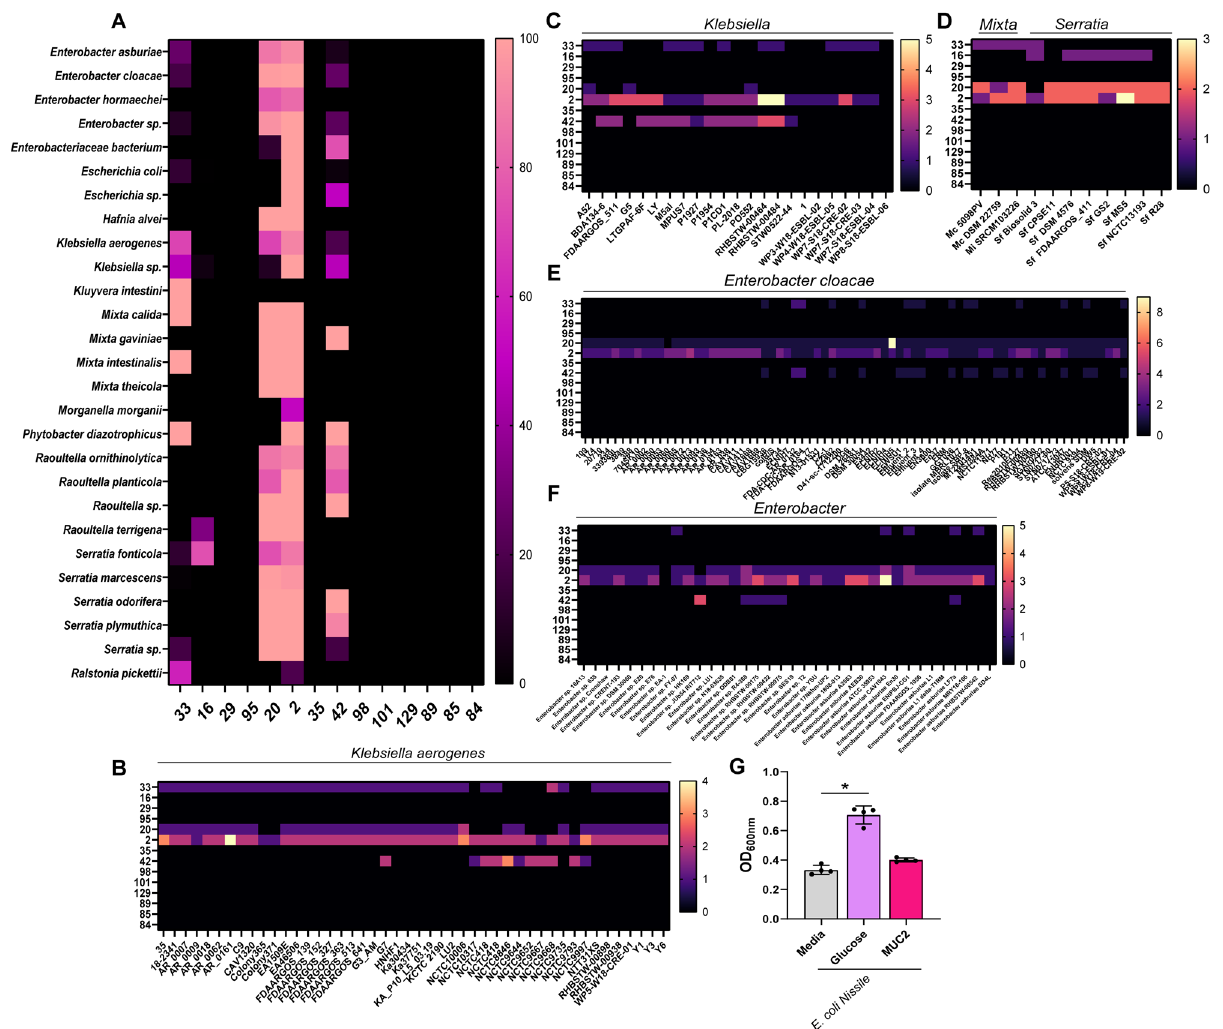
Figure 5. Mucin-related glycosyl hydrolase profiles in the Proteobacteria phlyum. ( A ) Heat map of the Proteobacteria genomes that have at least one gene copy of each mucin-associated GH 33, 16, 29, 95, 20, 2, 35, 42, 98, 101, 129, 89, 85, and 84. Heat map showing the gene copy number of mucin-associated GHs in the strains of ( B ) Klebsiella aerogenes , ( C ) Klebsiella spp., ( D ) Mixta calida, M. intestinalis, and Serratia fonticola, ( E ) Enterobacter cloacae , ( F ) Enterobacter spp. and E. asburiae. ( G ) Growth analysis of E. coli Nissle 1917 in a chemically defined media ZMB1 lacking glucose (media control), with glucose (positive control), or lacking glucose and supplemented with 1 mg/mL porcine intestinal MUC2. Growth was measured by examining the optical density at 600 nm (OD 600nm ) after overnight